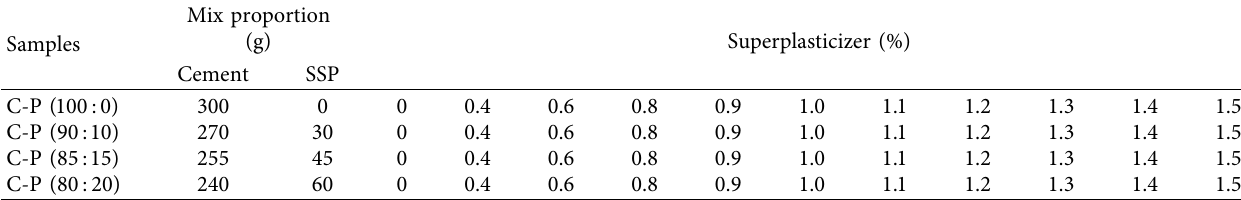
Figure 2: Particle morphology of SSP. (a) Magnify 1000 times. (b) Magnify 3000 times. Table 2: Mix proportions of the fluidity of cement paste.